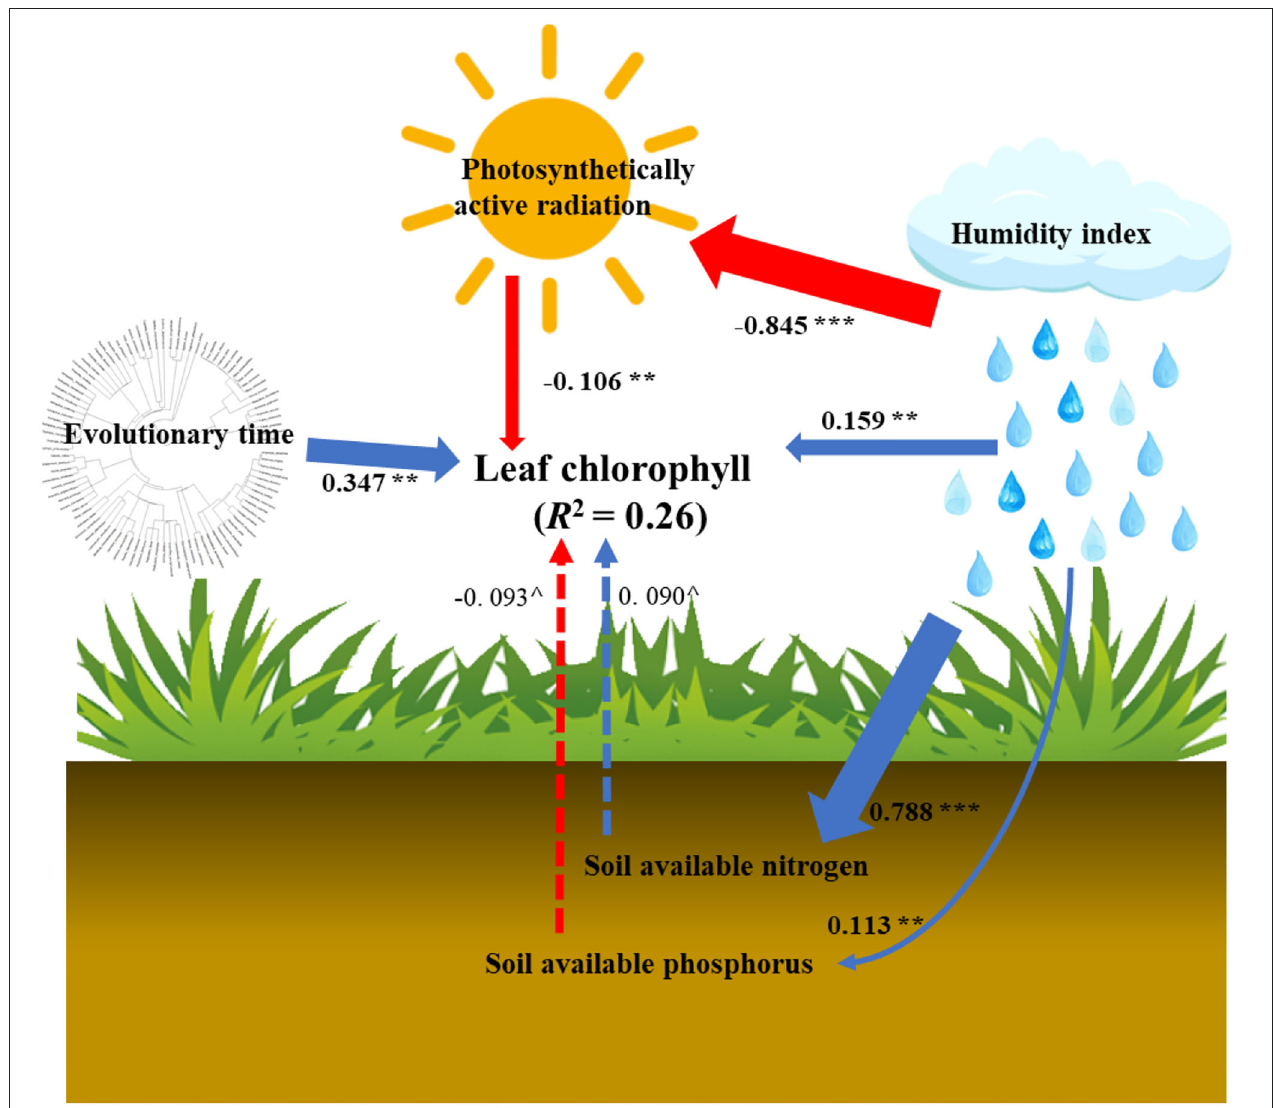
FIGURE 5 | The direct and indirect impact pathways of plant evolutionary time, climate [humidity index, photosynthetically active radiation (PAR)], and soil nutrient [soil available nitrogen (N) and phosphorus (P)] in determining leaf Chl variations. The solid lines indicate significant pathways, while dashed ones represent marginally significant pathways (0.05 < p < 0.1). Blue lines are positive pathways, while red ones mean negative pathways. The numbers near the arrows represent standardized path coefficients, and the arrow width is proportional to the size of path coefficients. Significance levels are indicated by ** p < 0.01; *** p < 0.001; ∧ p <